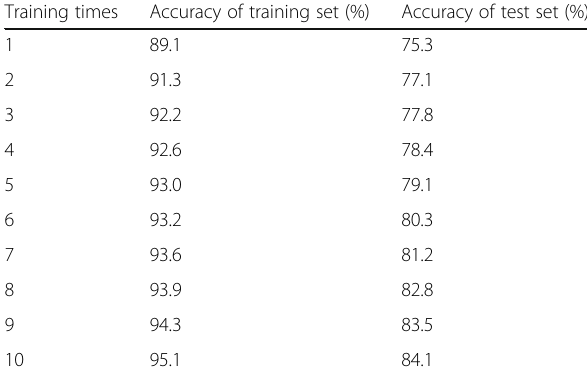
Table 2 Classification results of non-mixed models Training